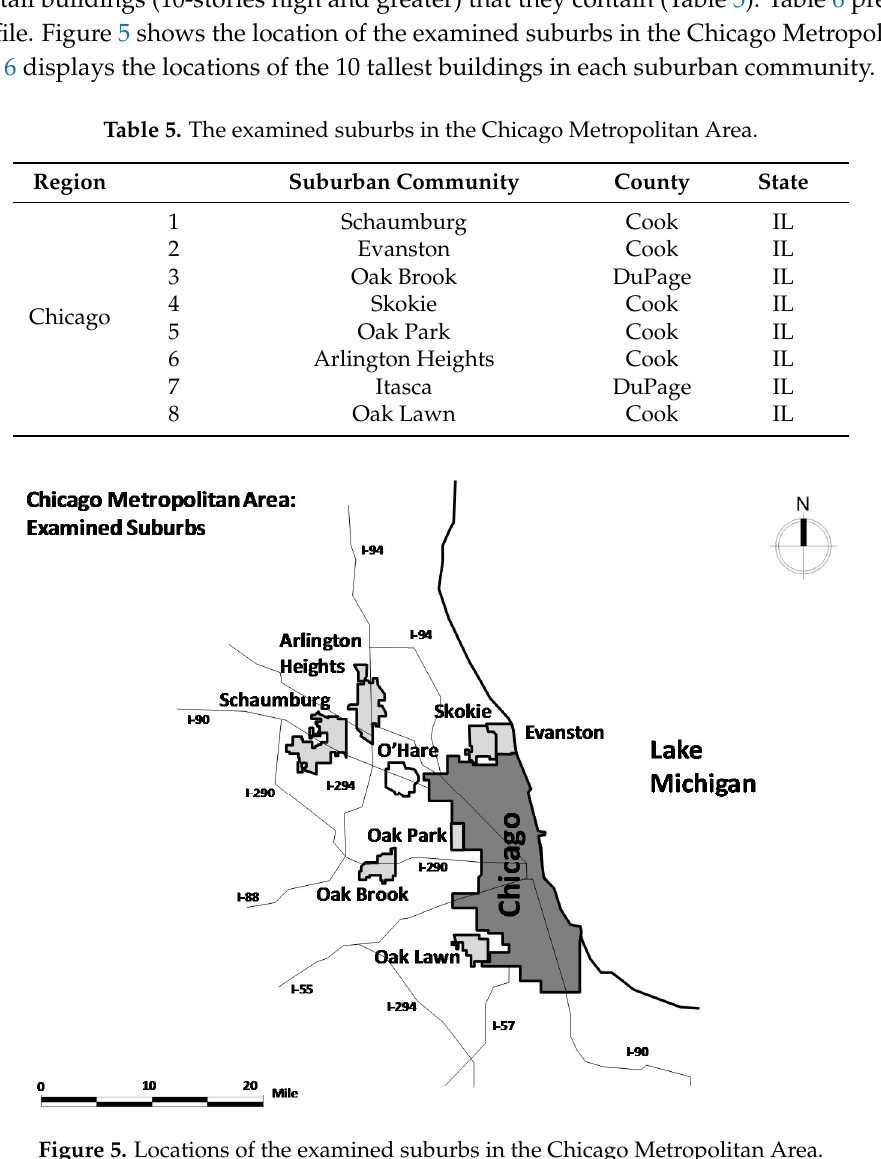
Figure 5. Locations of the examined suburbs in the Chicago Metropolitan Area.